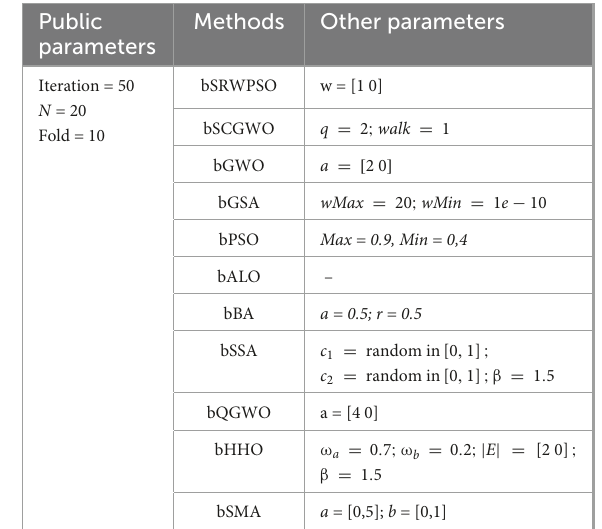
Supplementary Appendix Table 1 reflects the effects of TABLE 11 Key parameters of the